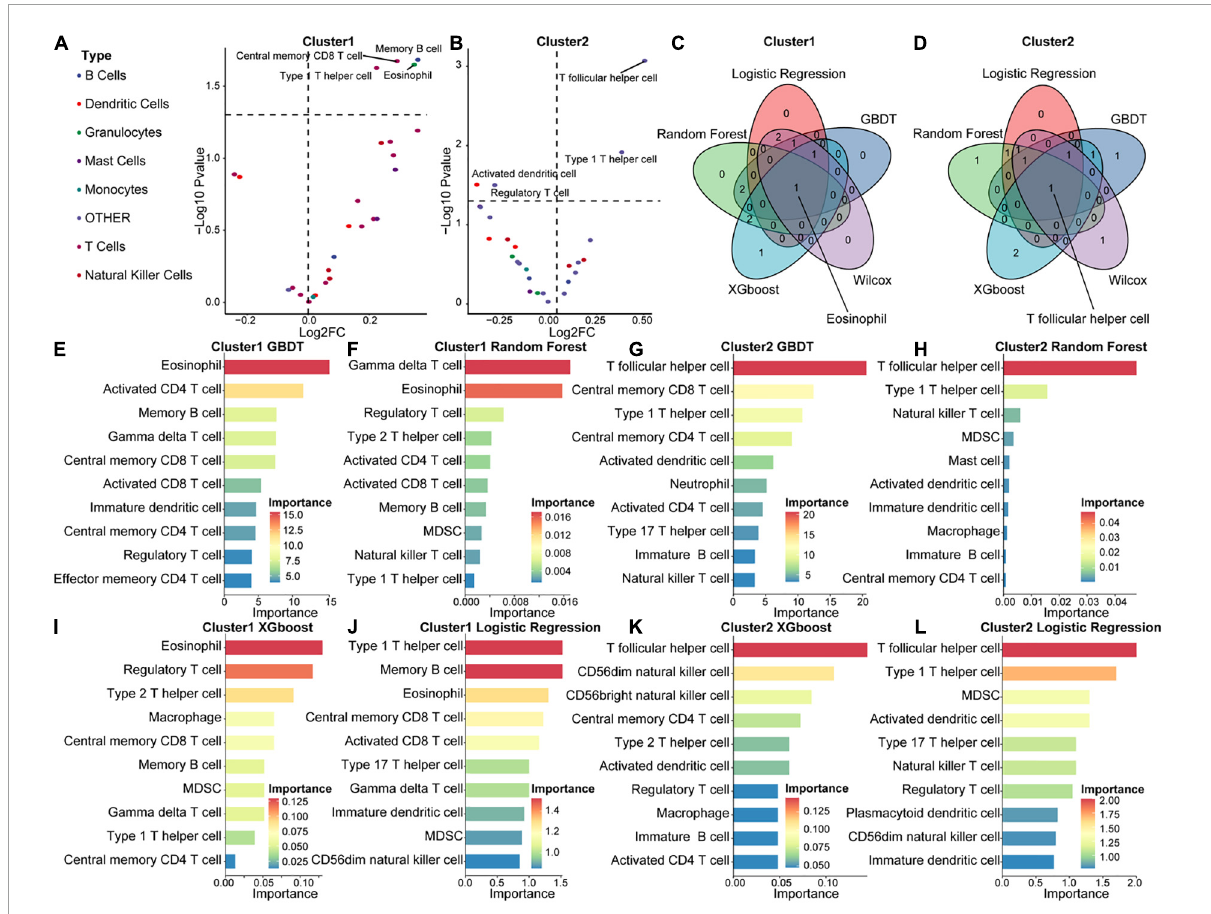
FIGURE8 Immunological composition and feature identification analysis of the molecular subtypes of acute SCI. (A,B) Volcano plots of differential expression of immune infiltrating cells in ASIA-high and -low groups in acute SCI subtypes Cluster 1 and Cluster 2. (C,D) Venn diagrams of logistic regression (LR), random forest (RF), GBDT, XGboost, and Wilcoxon analyses in the acute SCI subtypes Cluster 1 and Cluster 2. (E,F) Histogram of GBDT and RF classifiers in the acute SCI subtype Cluster 1. The horizontal coordinates and colors indicate importance and the vertical coordinate indicates immune infiltrating cells. (G,H) Histogram of GBDT and RF classifiers in acute SCI subtype Cluster 2. The horizontal coordinates and colors indicate importance and the vertical coordinate indicates immune infiltrating cells. (I,J) Histogram of XGboost and LR classifiers in the acute SCI subtype Cluster 1. The horizontal coordinates and colors indicate importance and the vertical coordinate indicates immune infiltrating cells. (K,L) Histogram of XGboost and LR classifiers in the acute SCI subtype Cluster 2. The horizontal coordinates and colors indicate importance and the vertical coordinate indicates immune infiltrating